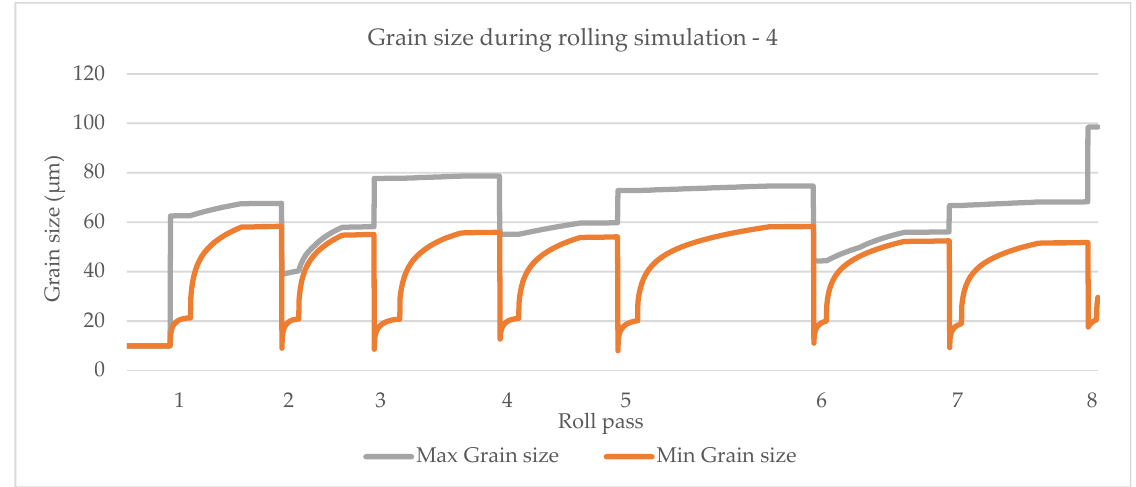
Figure 17. Simulation of maximum and minimum grain size based on the model by Hodgson and Gibbs [10].